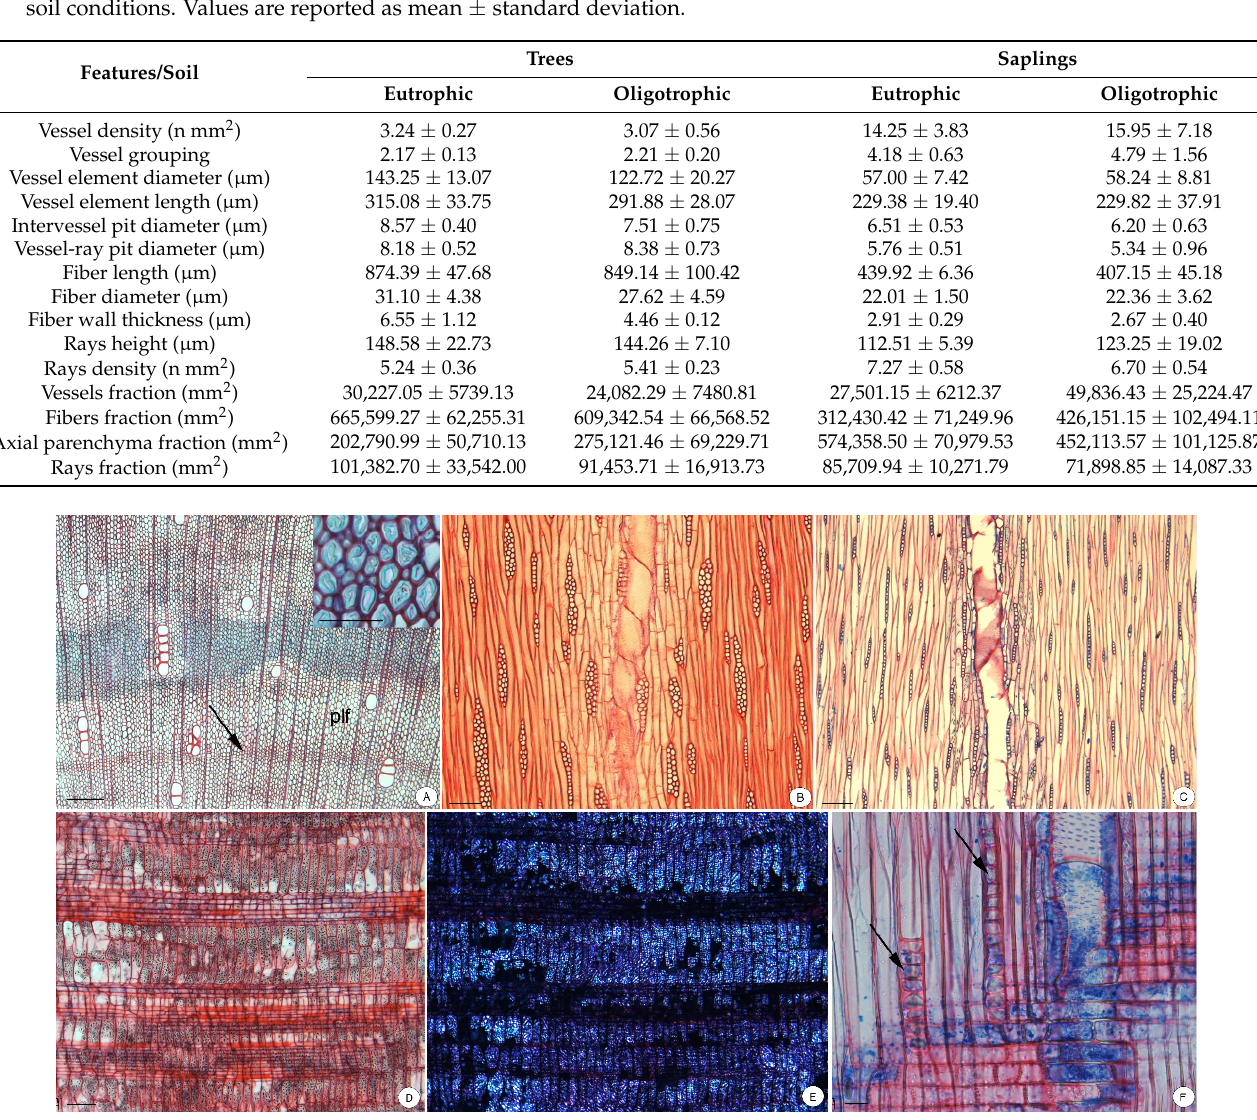
Figure 3. Wood of Enterolobium contortisiliquum . ( A ). Larger amount of gelatinous fibers in the stem of a 2-year-old sapling. Inset: Higher magnification of gelatinous fibers. Note also the growth rings delimited by flattened and thick-walled latewood fibers (arrow), wood diffuse-porous, paratracheal axial parenchyma, and parenchyma-like fibers (plf). ( B , C ). Tangential sections. Rays 1 to 3 cells wide ( B ) in the stem of 9-year-old tree, and uniseriate ( C ) in the stem of a 2-year-old sapling. Note also 2 to 4 cells per axial parenchyma strand ( B , C ). ( D , E ). Starch grains in axial parenchyma cells and parenchyma-like fibers seen under light microscopy ( D ) and shine under polarized light ( E ) in 2-year-old saplings. F. Prismatic crystals (arrows) in chambered axial parenchyma cells in xylem of a 2-year-old sapling. Bars = 200 µm in A; 50 µm inset; 100 µm in ( B – E ); 20 µm in ( F ).